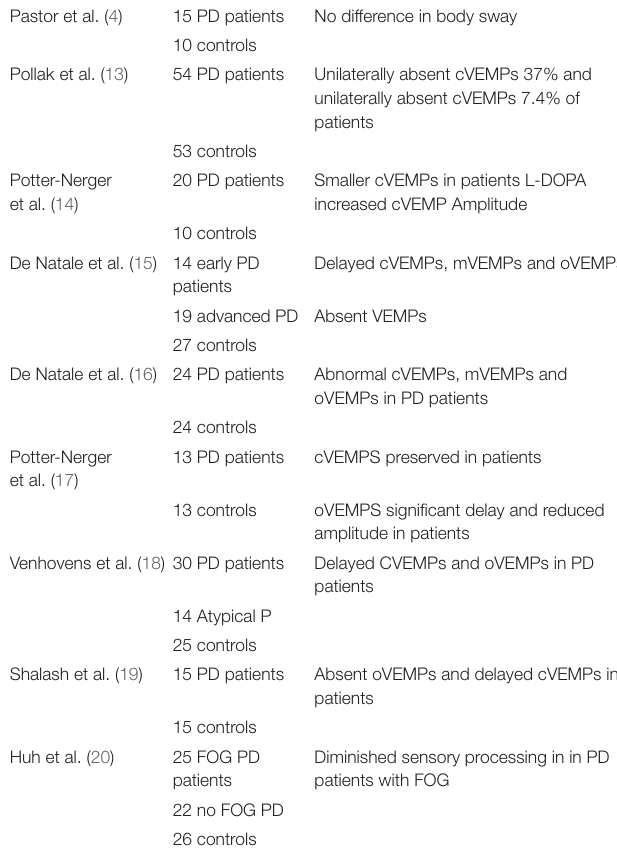
TABLE 2 | A summary of studies examining posture and VEMPs in PD patients. Pastor et al.